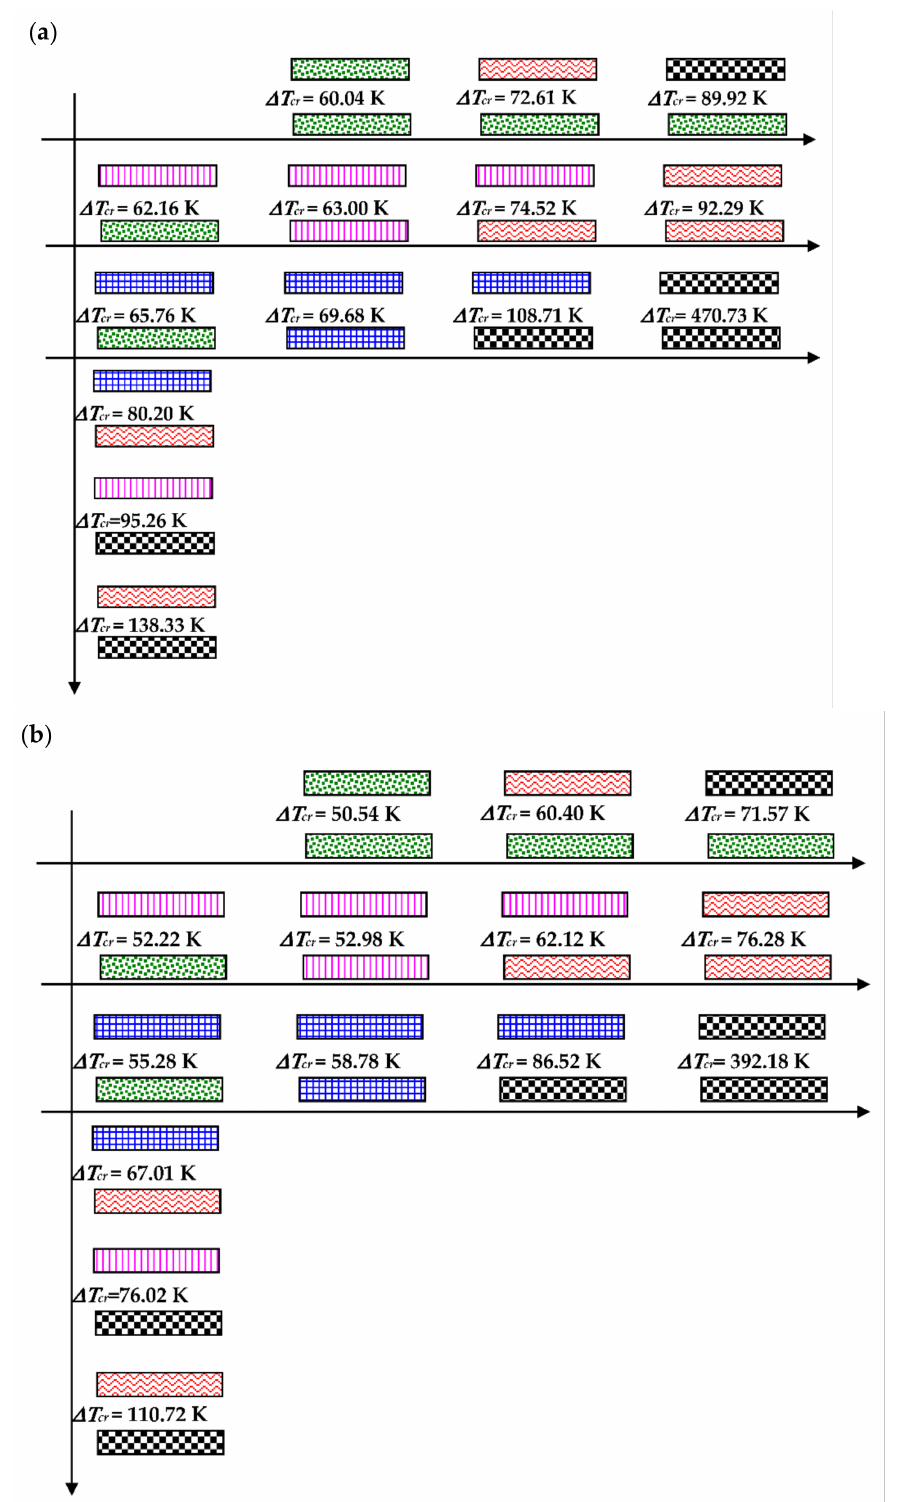
Figure 6. Distribution of the values of critical, temperature differences ∆ T cr depending on a form of the structure failure for thermally orthotropic plate subjected to a positive ( a ), negative ( b ) tempera- ture